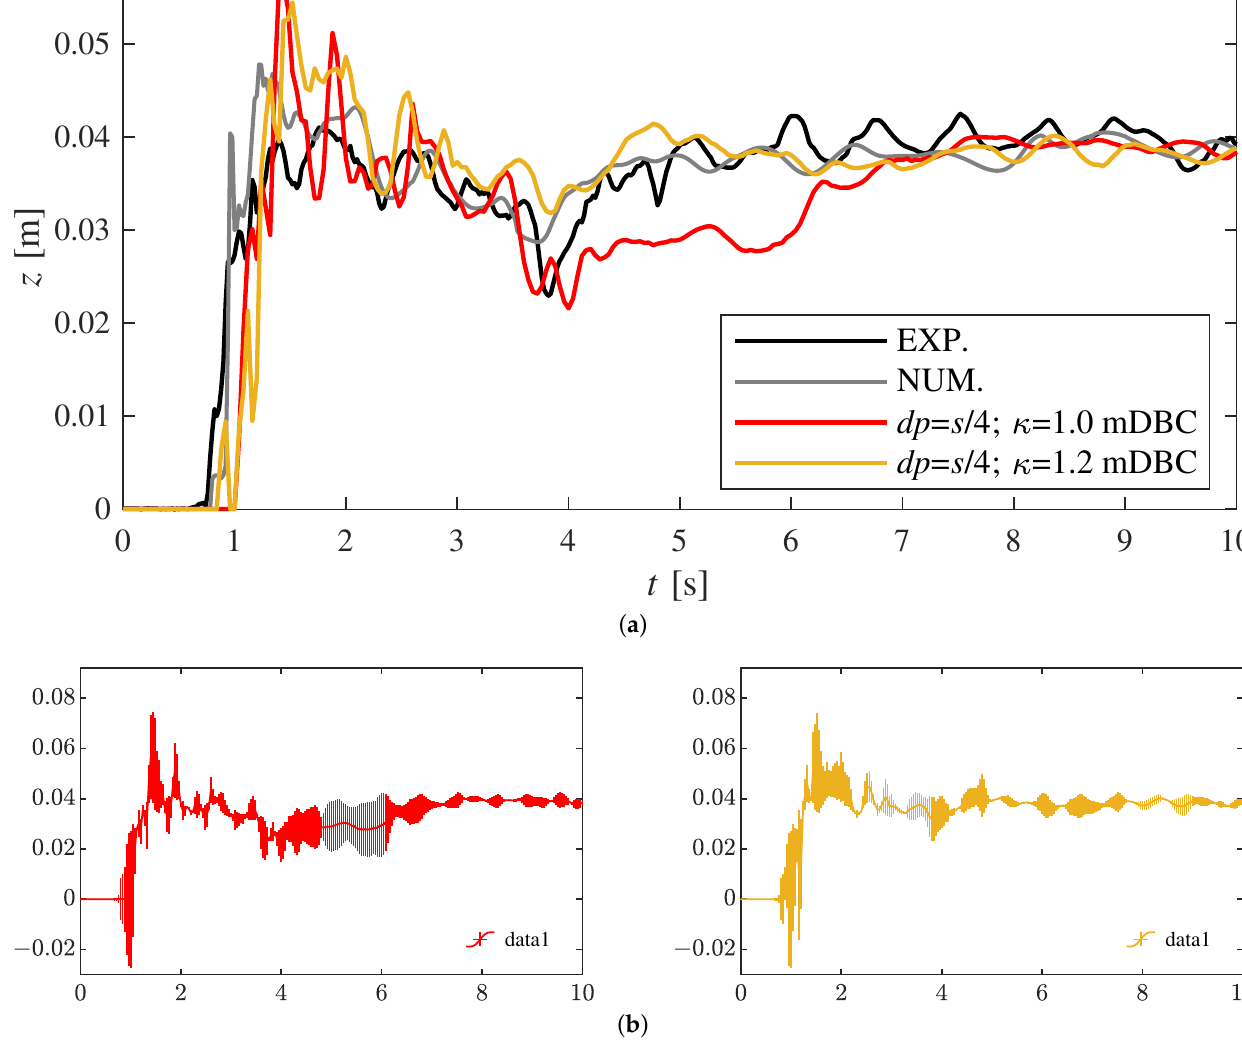
Figure 13. Overall comparison, including numerical reference, at P5 ( a ) and relative error ( b